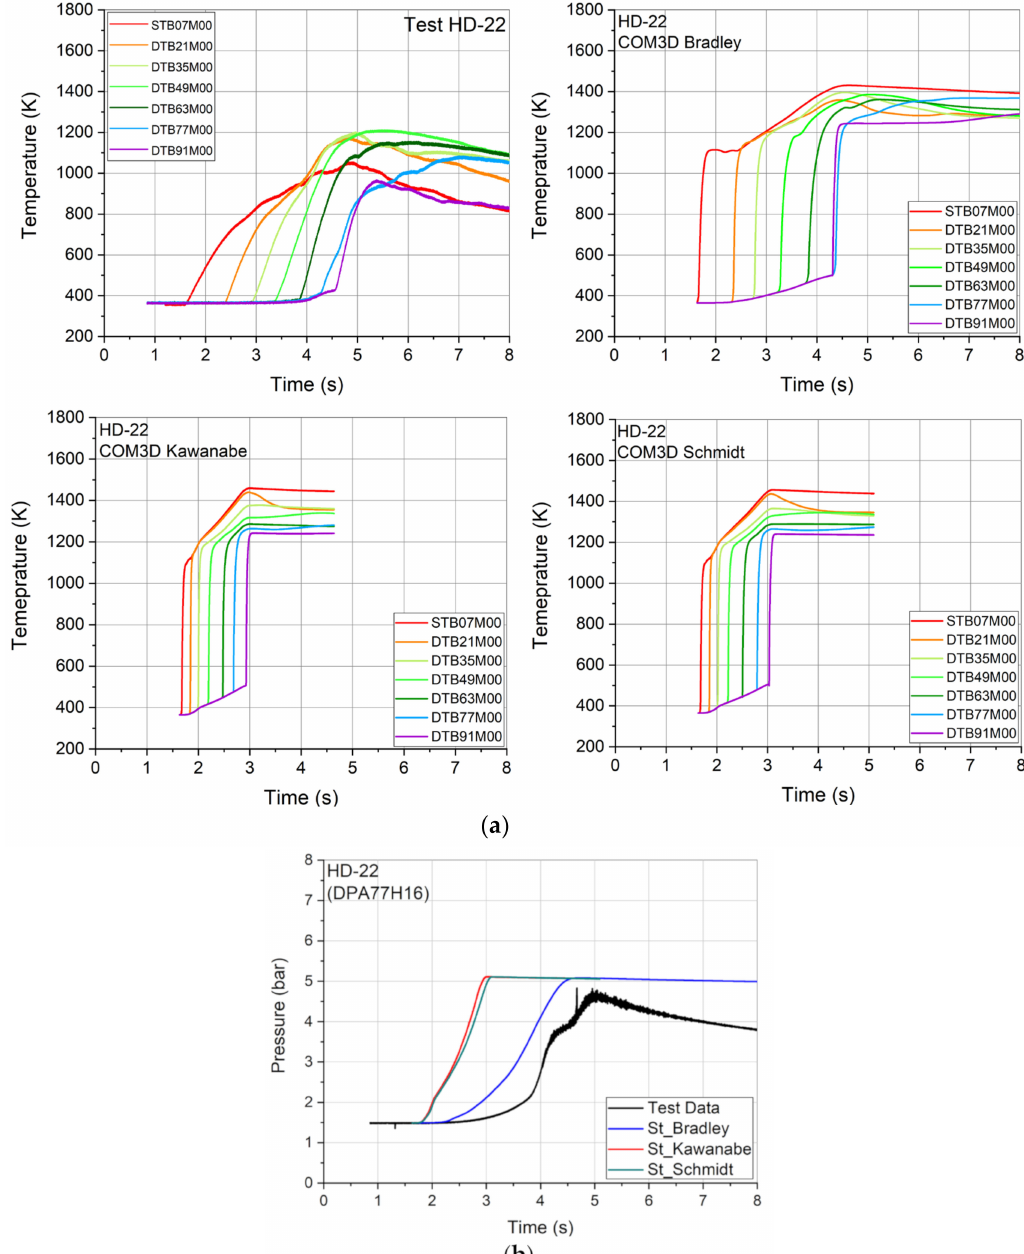
Figure 5. COM3D results for the THAI test HD-22. ( a ) Measured and calculated temperatures along the centerline of the vessel. ( b ) Comparison of pressure at the elevation 7.7 m between the test data and the COM3D